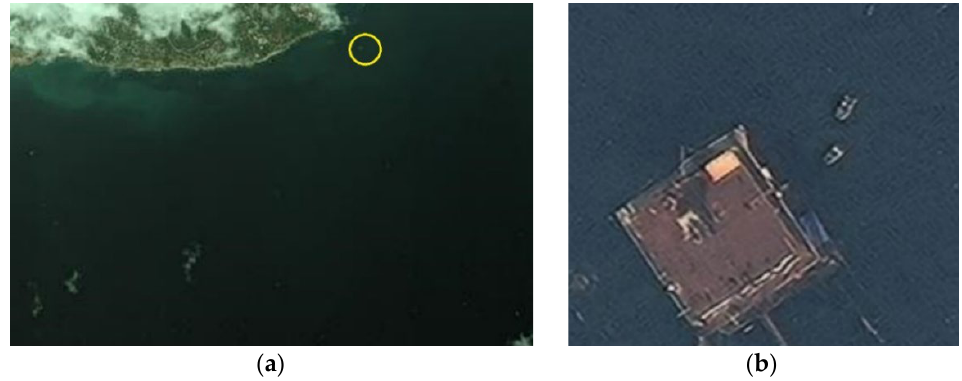
Figure 2. ( a ) Quicklook of a test WorldView-3 image obtained on 20 September 2021. The position of the hydrophysical platform, where complex experiments were carried out, is marked with yellow; ( b ) enlarged view of the hydrophysical platform.